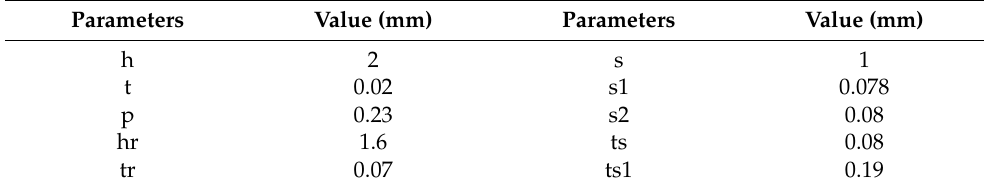
Figure 2. ( a ) Dimensional parameters of the MDSRL-RSML SWS; ( b ) rhombus-shaped meander-line. The periodic length and the transverse length of the meander-line are represented by p and h, respectively. Table 2 shows the main dimensional parameters of the MDSRL-RSML SWS. Table 2. Optimized dimensional parameters of the MDSRL-RSML SWS.